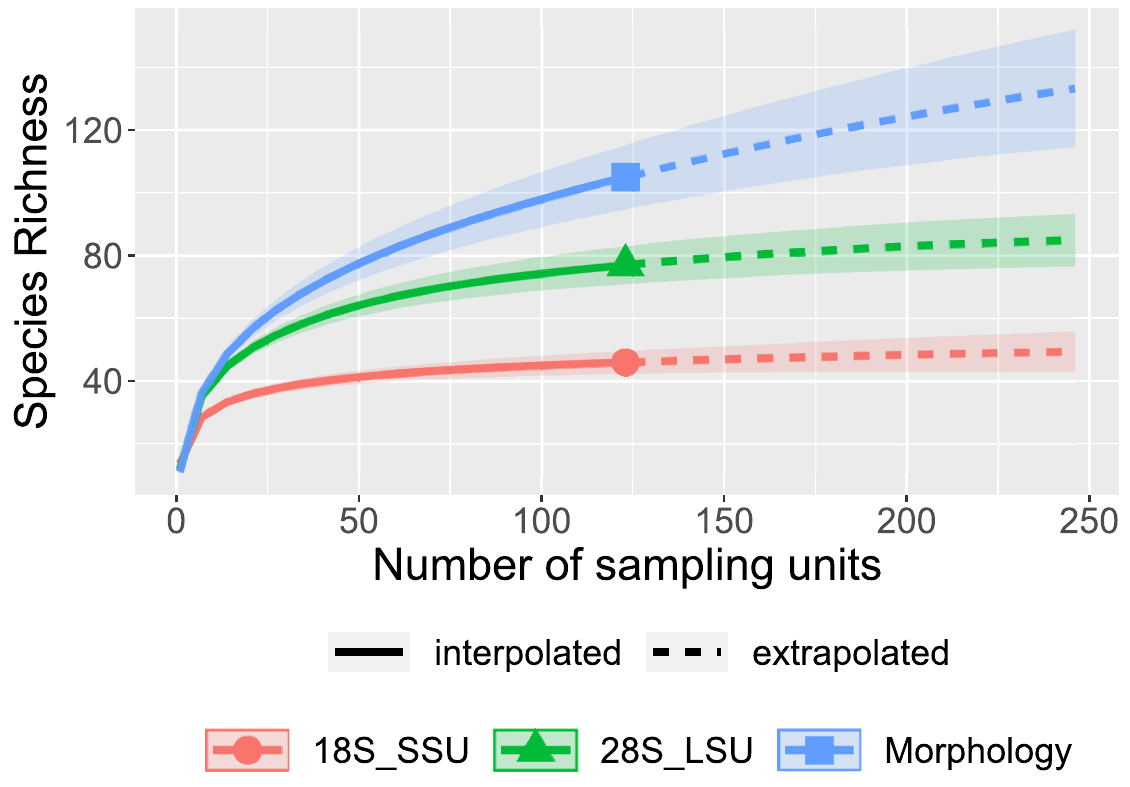
Fig 2. Comparison of species discovery rates. Rarefaction curves showing the expected number of species (vertical axis) relative to the number of sampling units (horizontal axis), for the 18S SSU locus, 28S LSU locus, and the morphological specimen identifications.